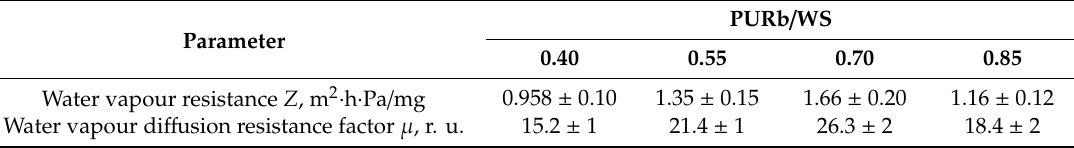
Figure 10. Short-term water absorption by partial immersion of PUR biocomposite foams. WS— cleaned sawdust, ο —single values from water absorption measurements, ● —average value from water absorption measurements. Table 6. Water vapour permeability results of PUR biocomposite foams.